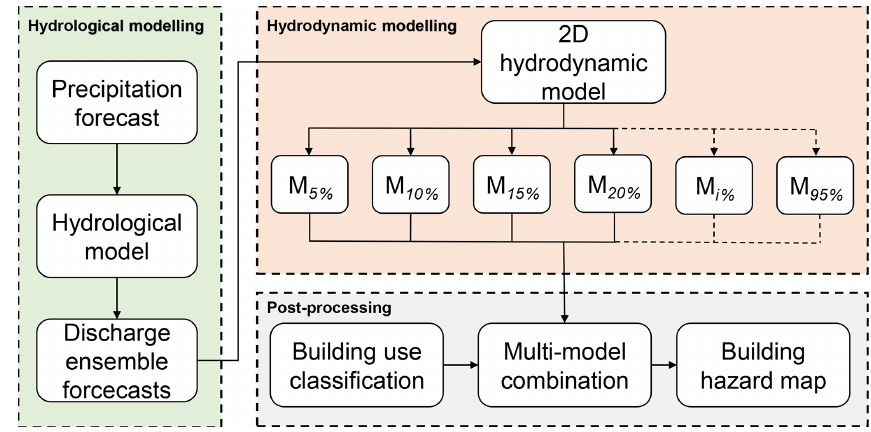
Figure 1. Schematic view of the methodology used to generate building hazard maps. The major components consist of the operational hydrological ensemble forecasts (Beg et al., 2018), the hydrodynamic model and post-processing that includes the multi-model combination. M x % denotes the HD model results generated using x % percentile discharge.